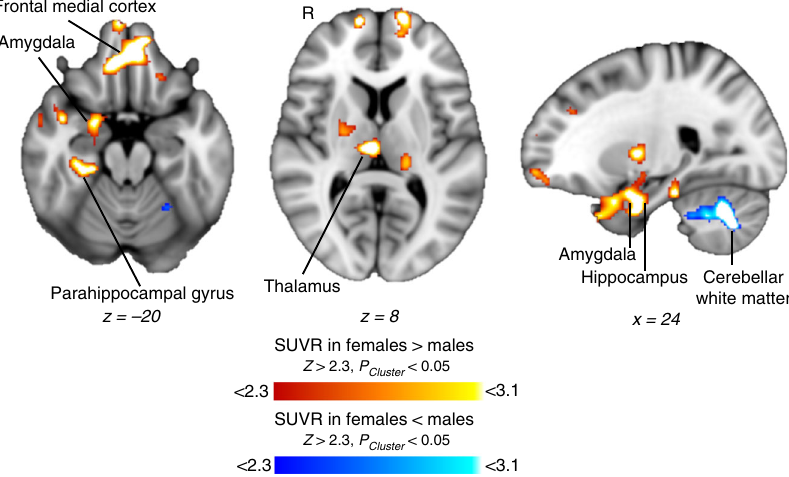
Fig. 4 [ 11 C]Martinostat uptake shows sex-speci fi c differences. Voxel-wise comparison of SUVR between females ( n = 20) and males ( n = 21), controlled for age, total grey matter volume/intracranial volume, white matter volume/intracranial volume and cerebrospinal fl uid volume/intracranial volume. Statistical maps were overlaid onto the MNI 1 mm template in radiological orientation (two-tailed unpaired t -test; Z > 2.3 , P Cluster < 0.05). Red – yellow represents regions signi fi cantly increased in females compared to males and blue-light blue represents regions signi fi cantly decreased in females compared to